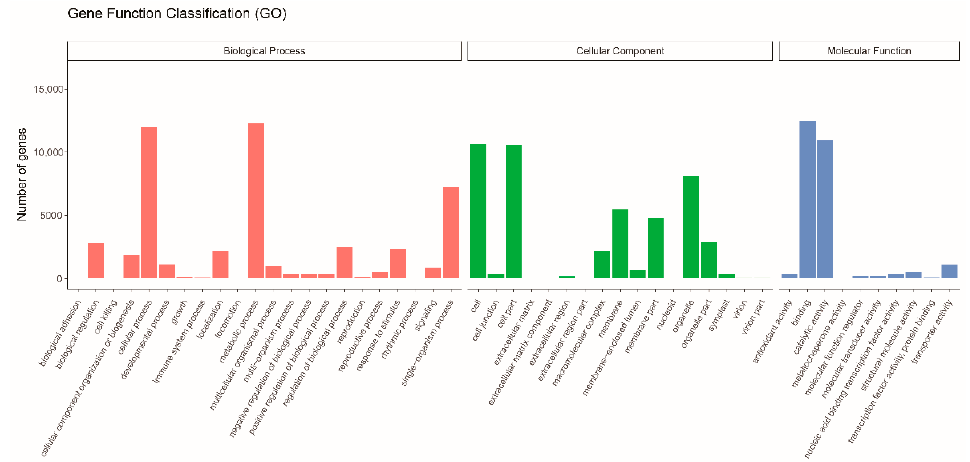
Figure 2. Gene ontology classification of Larix kaempferi transcriptome. Unigenes were annotated to three categories: Biological Process (red), Cellular Component (green), and Molecular Function (blue).